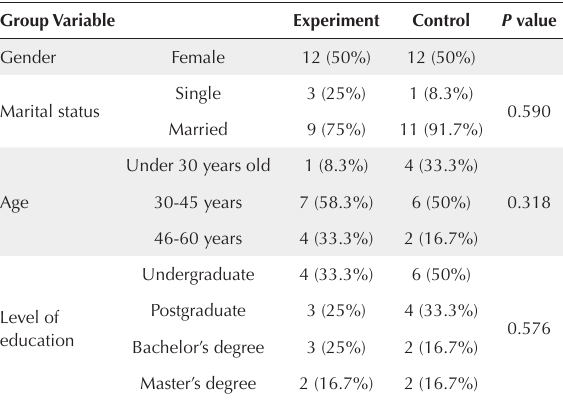
Table 2. Mean ± SD of research variables in experimental and control groups Group Variable Experiment